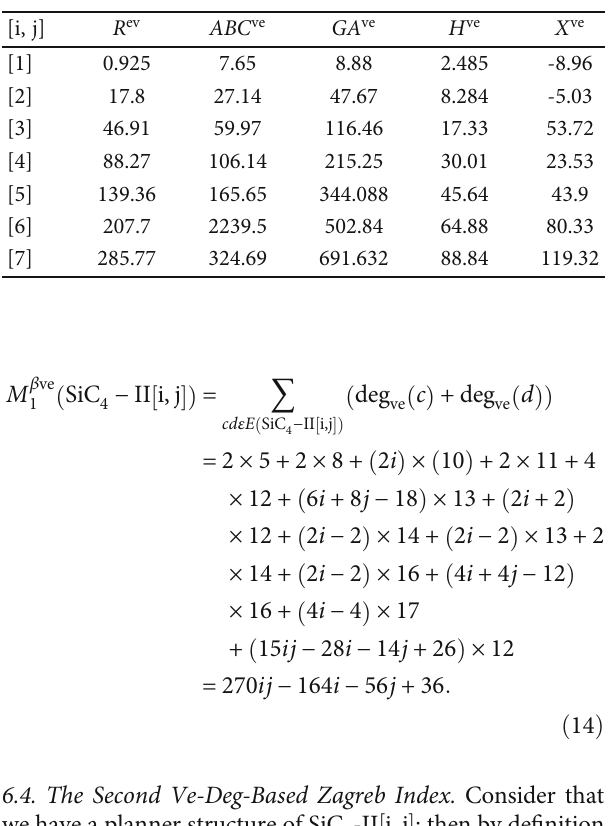
- II ½ i , j (cid:2) 4